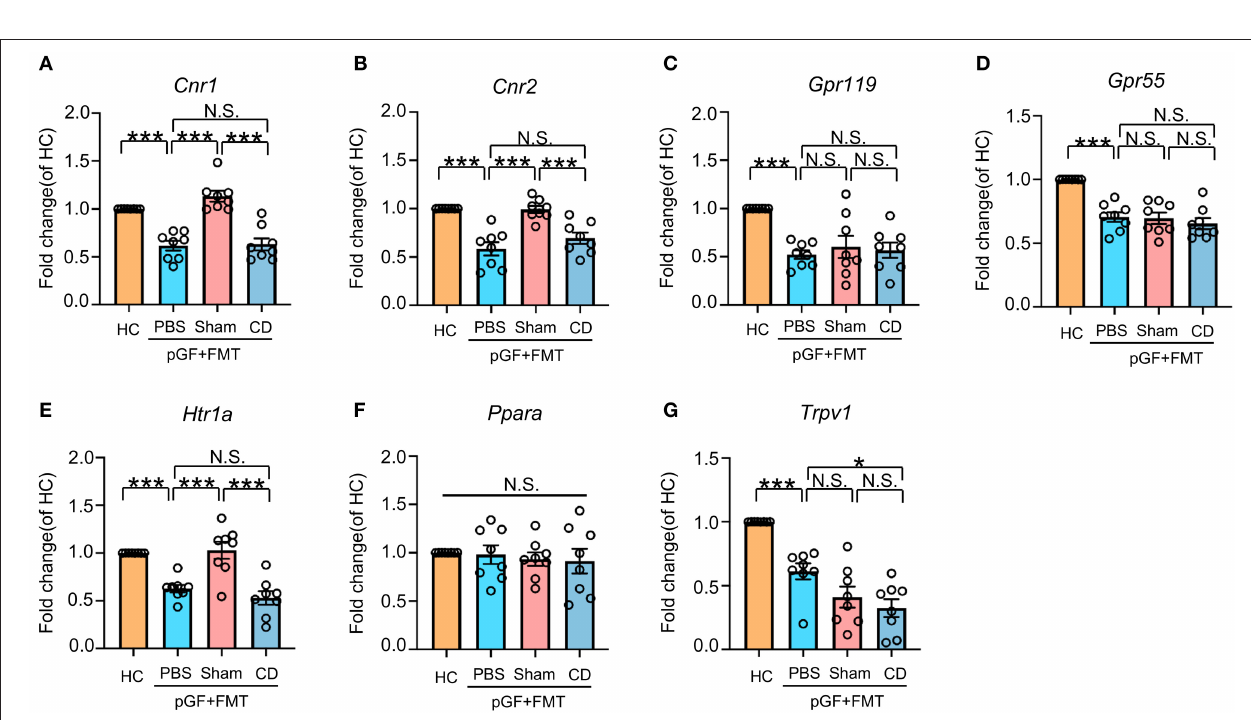
FIGURE 7 | Effects of fecal microbiota transplantation from mice in Sham and CD groups on endocannabinoid (eCB) receptors in pGF mice. (A) Cnr1 [one-way ANOVA; F (2, 21) = 28.23, P < 0.001]. (B) Cnr2 [one-way ANOVA; F (2, 21) = 18.87, P < 0.001]. (C) Gpr119 [one-way ANOVA; F (2, 21) = 9.10, P < 0.001]. (D) Gpr55 [one-way ANOVA; F (2, 21) = 19.09, P < 0.001]. (E) Htr1a [one-way ANOVA; F (2, 21) = 17.74, P < 0.001]. (F) Ppara [one-way ANOVA; F (2, 21) = 0.21, P > 0.05]. (G) Trpv1 [one-way ANOVA; F (2, 21) = 23.48, P < 0.001]. Data are presented as means ± SEM ( n = 8 per group) and analyzed by one-way ANOVA followed by Tukey’s post hoc test. * P < 0.05, ** P < 0.01, *** P < 0.001. CD, cognitive dysfunction; FMT, fecal microbiota transplantation; HC, healthy control; N.S., not significant; pGF, pseudo-germ-free